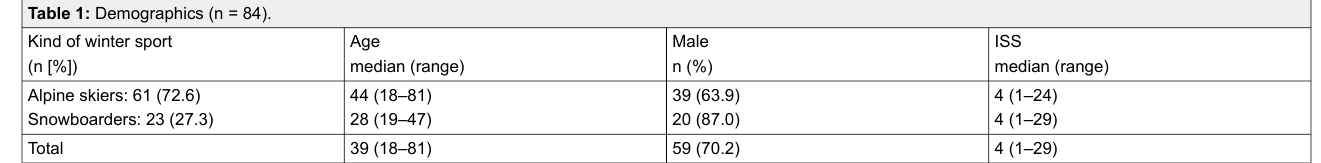
Age median (range)